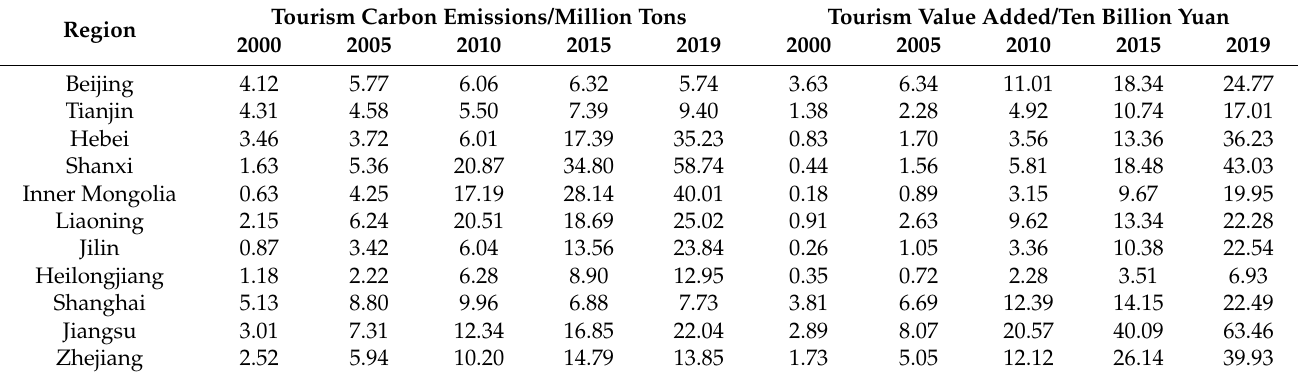
Table 2. The results of tourism value added and tourism carbon emissions from 2000 to